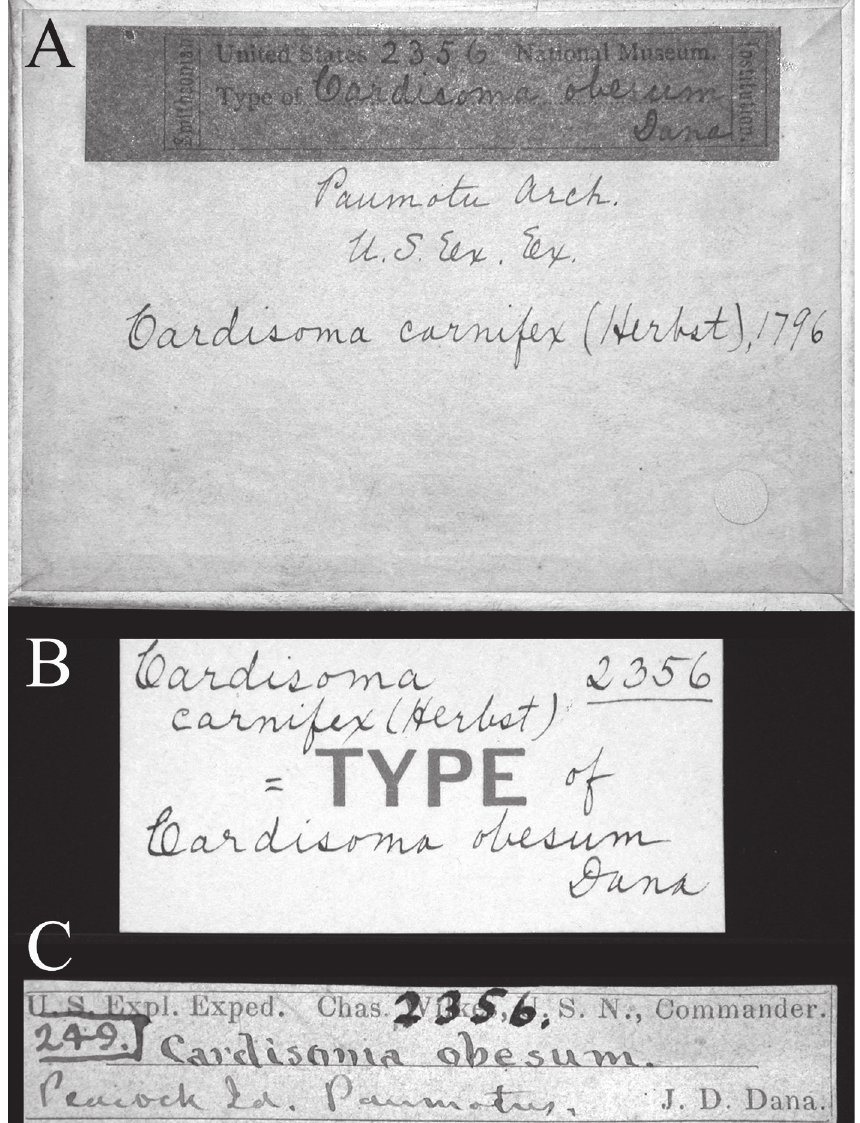
Figure 4. Labels associated with the lectotype of Cardisoma obesum Dana, 1851. A, box cover; B, C, labels inside